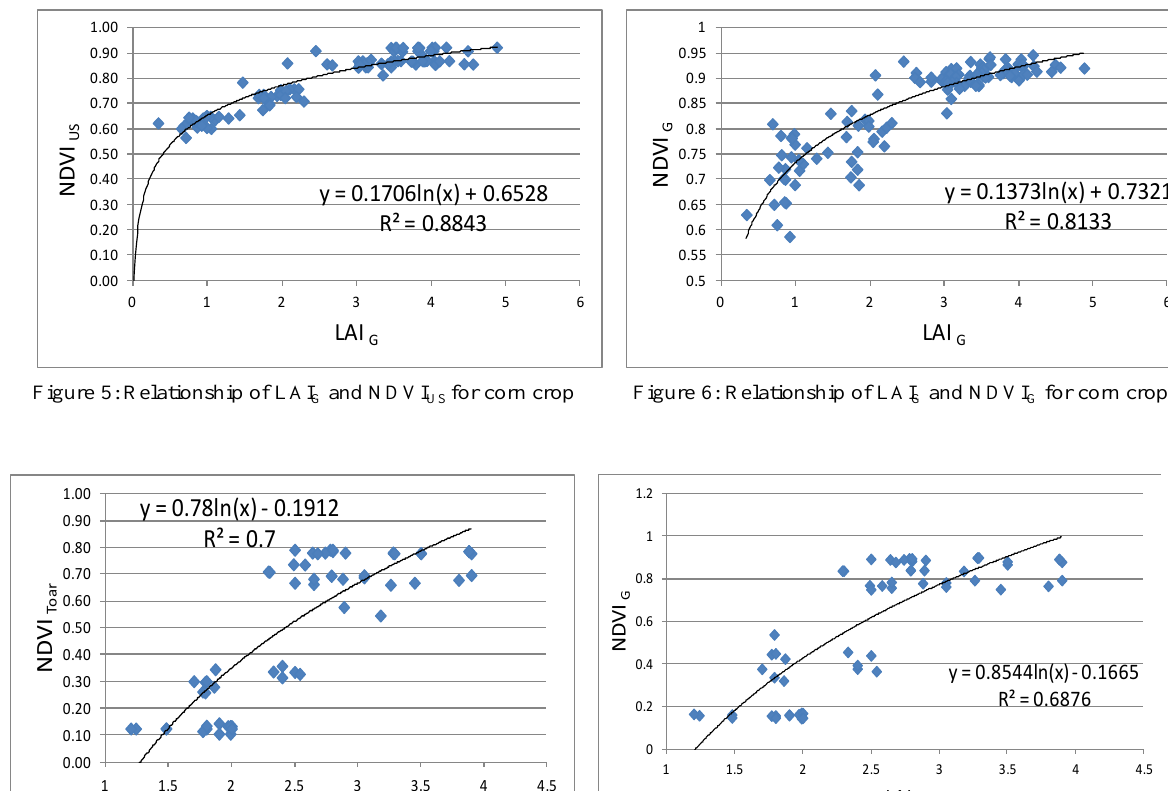
Figure 8: Relationship of LAI G and NDVI G for wheat crop